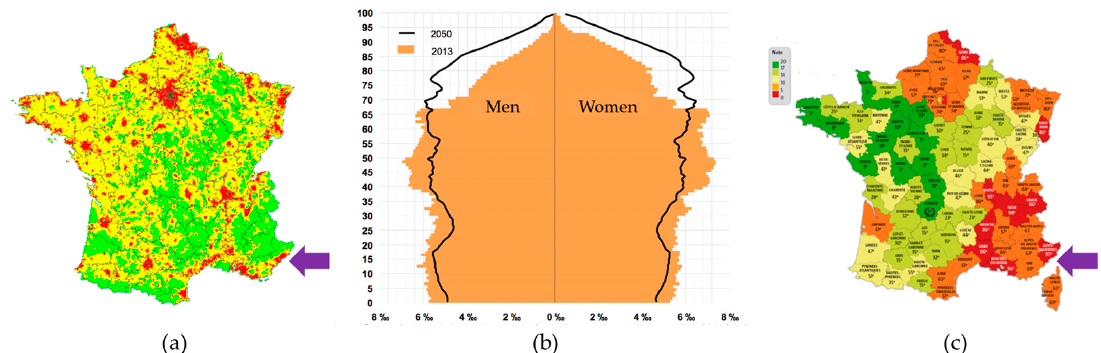
Figure 2. ( a ) High population density within the Alpes-Maritimes area (purple arrow) (INSEE data). ( b ) Age pyramid within the Alpes-Maritimes area in 2013 and pre-visions for 2050 (INSEE data). ( c ) Air pollution levels (in red, very high air pollution) within the Alpes-Maritimes area (purple arrow; www.prevair.org).